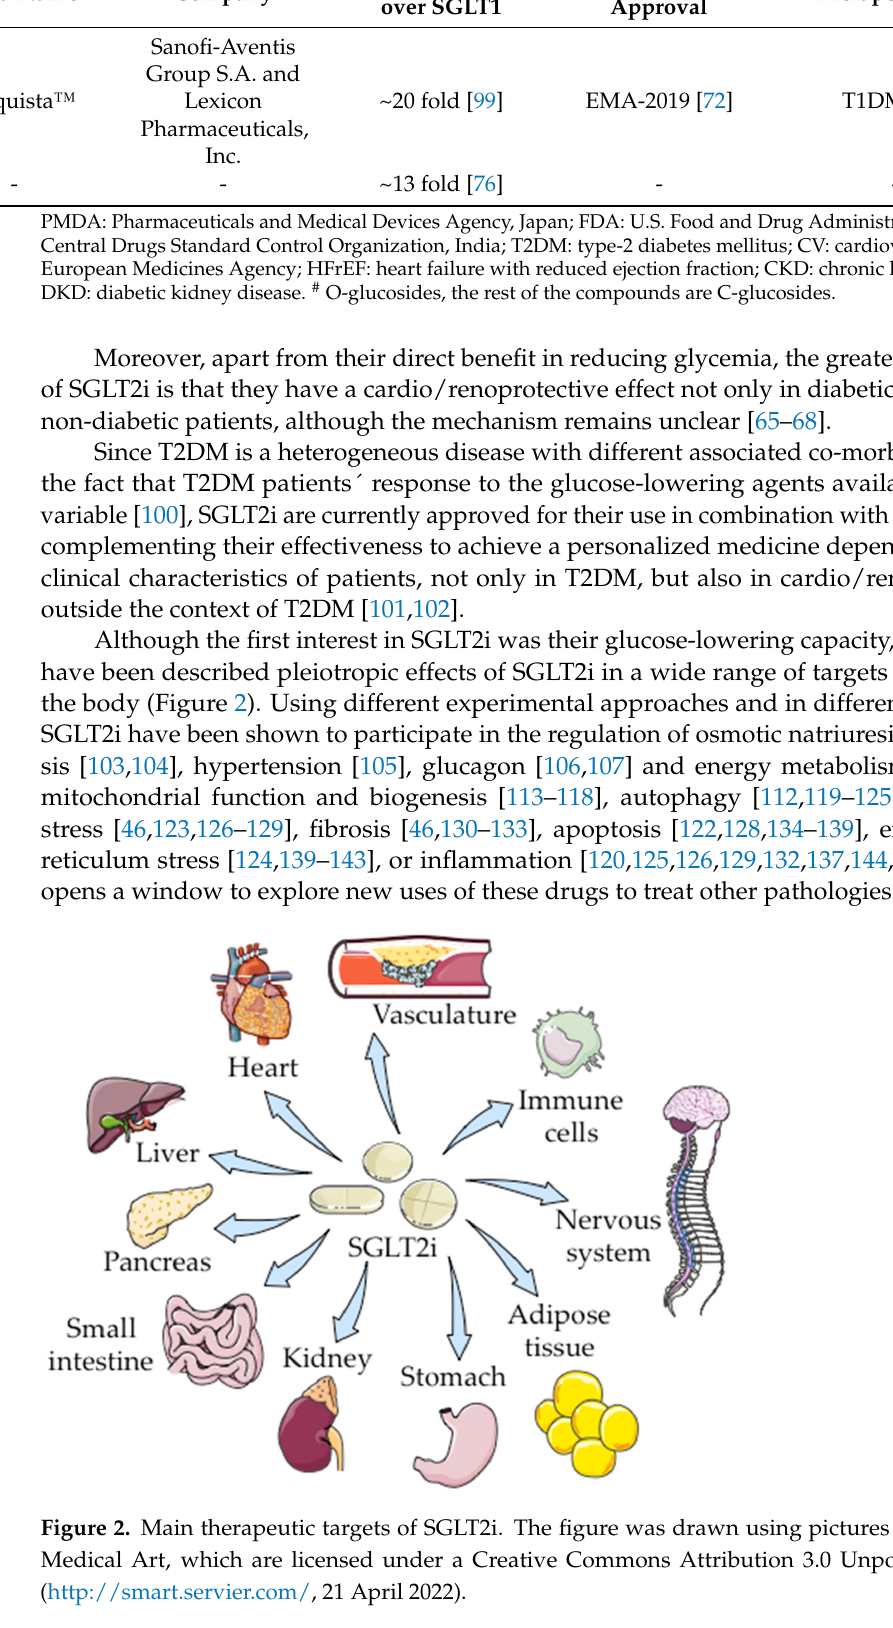
Figure 2. Main therapeutic targets of SGLT2i. The figure was drawn using pictures from Servier Medical Art, which are licensed under a Creative Commons Attribution 3.0 Unported License (http://smart.servier.com/, 21 April 2022). 4. SGLT2i and Inflammation On one hand, as mentioned in the introduction of this review, phlorizin, the first nat- ural SGLT1/2 inhibitor discovered, is a molecule that has anti-inflammatory properties [146–148], along with other natural and synthetic chalcones and flavonoids [149–151]. On the other hand, the fact that inflammation and metabolism have a strong interplay and that their deregulation drives the development of several diseases is becoming increas- ingly evident. Normal cellular homeostasis relies on the crosstalk between the immune system and metabolic regulation in such a way that the pathogenesis of metabolic disor- ders is often triggered by or associated with inflammatory processes [152–156]. In keeping with this, many authors have started to refer to this fact as metaflammation [157,158]. Taking into account that synthetic SGLT2i are based on the chemical structure of phlorizin, the close interplay between inflammation and metabolic deregulation, and the positive effects of SGLT2i observed in pathologies with metabolic and inflammatory de- rangement, such as T2DM [159], heart failure [160], diabetic cardiomyopathy [161], dia- betic nephropathy [162] , or NAFLD [163], it was natural to explore their role as potential therapeutic agents to treat inflammation. Recently, several studies have described the anti-inflammatory effect of SGLT2i using different experimental approaches (Figure 3)